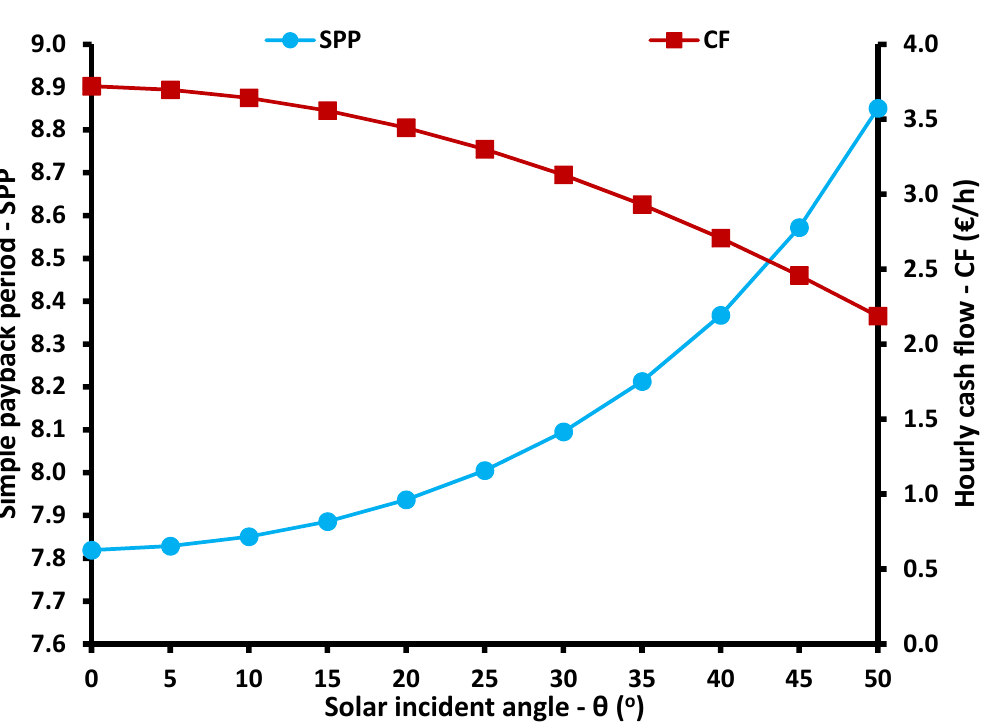
Figure 22. Simple payback period and hourly cash flow for different solar angles.